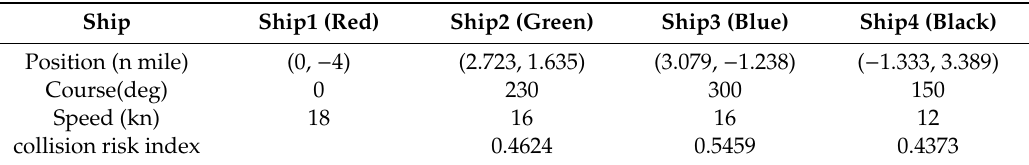
Table 1. Parameters of the initial multi-ship encounter situation.